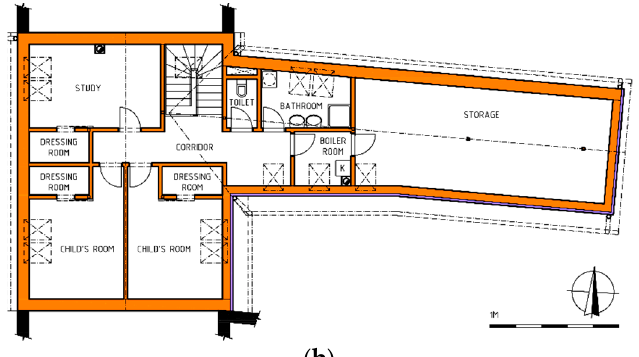
Figure 2. Renovated terraced house evaluated in V-2 LCA: ( a ) ground floor plan and ( b ) habitable attic plan with coloured hatching indicating different construction materials. Black = envelope walls of adjacent houses, grey = original structures, orange = hollow ceramic blocks, purple = additional EPS thermal insulation of the façade.